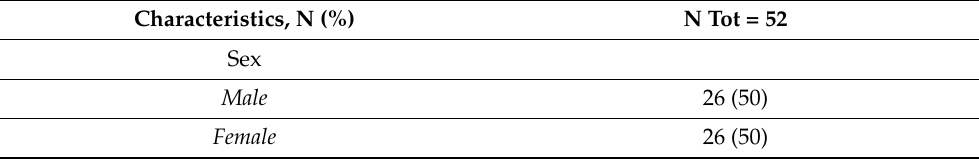
Table 1. Patient characteristics.